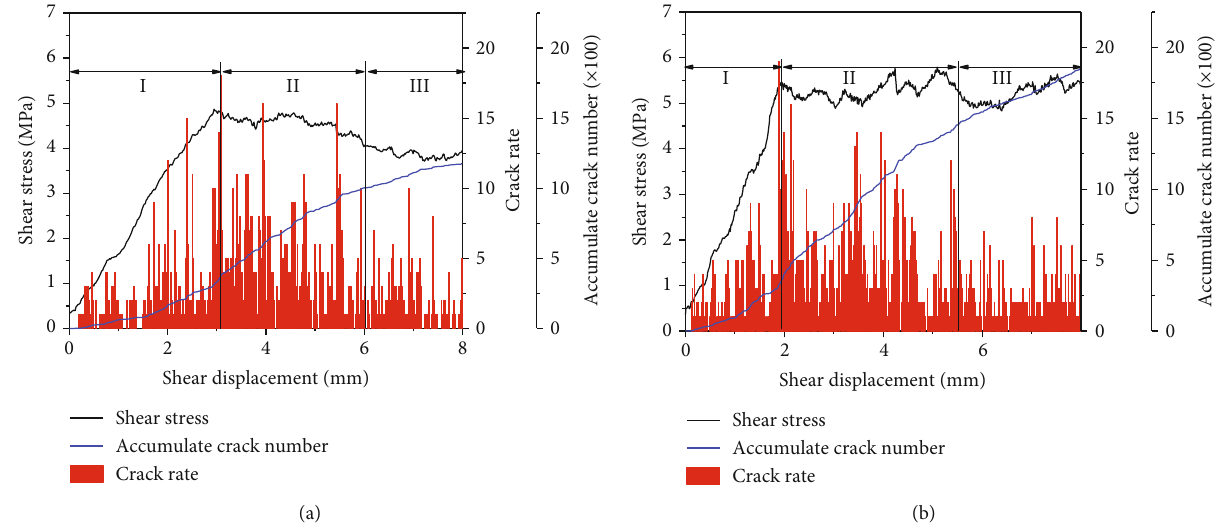
Figure 10: Number of cracks and cumulative number of cracks: (a) low-strength rock joints; (b) high-strength rock